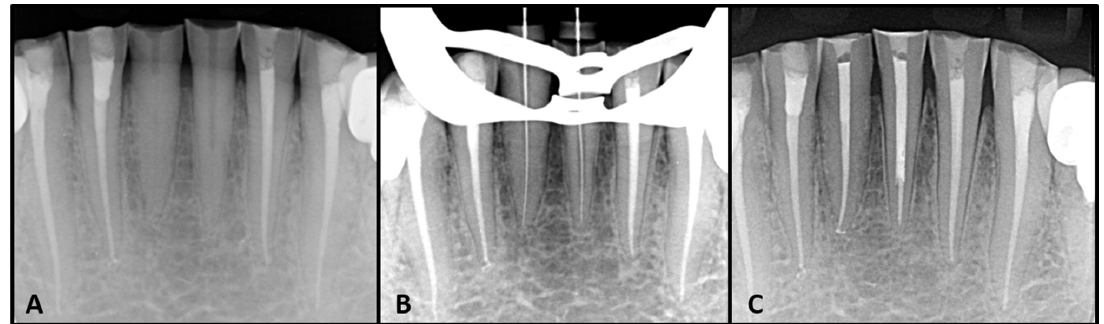
Figure 5. ( A ) Pre-operative X ray after micro-guided drilling. ( B ) Working length determination. ( C ) Post obturation and filling.